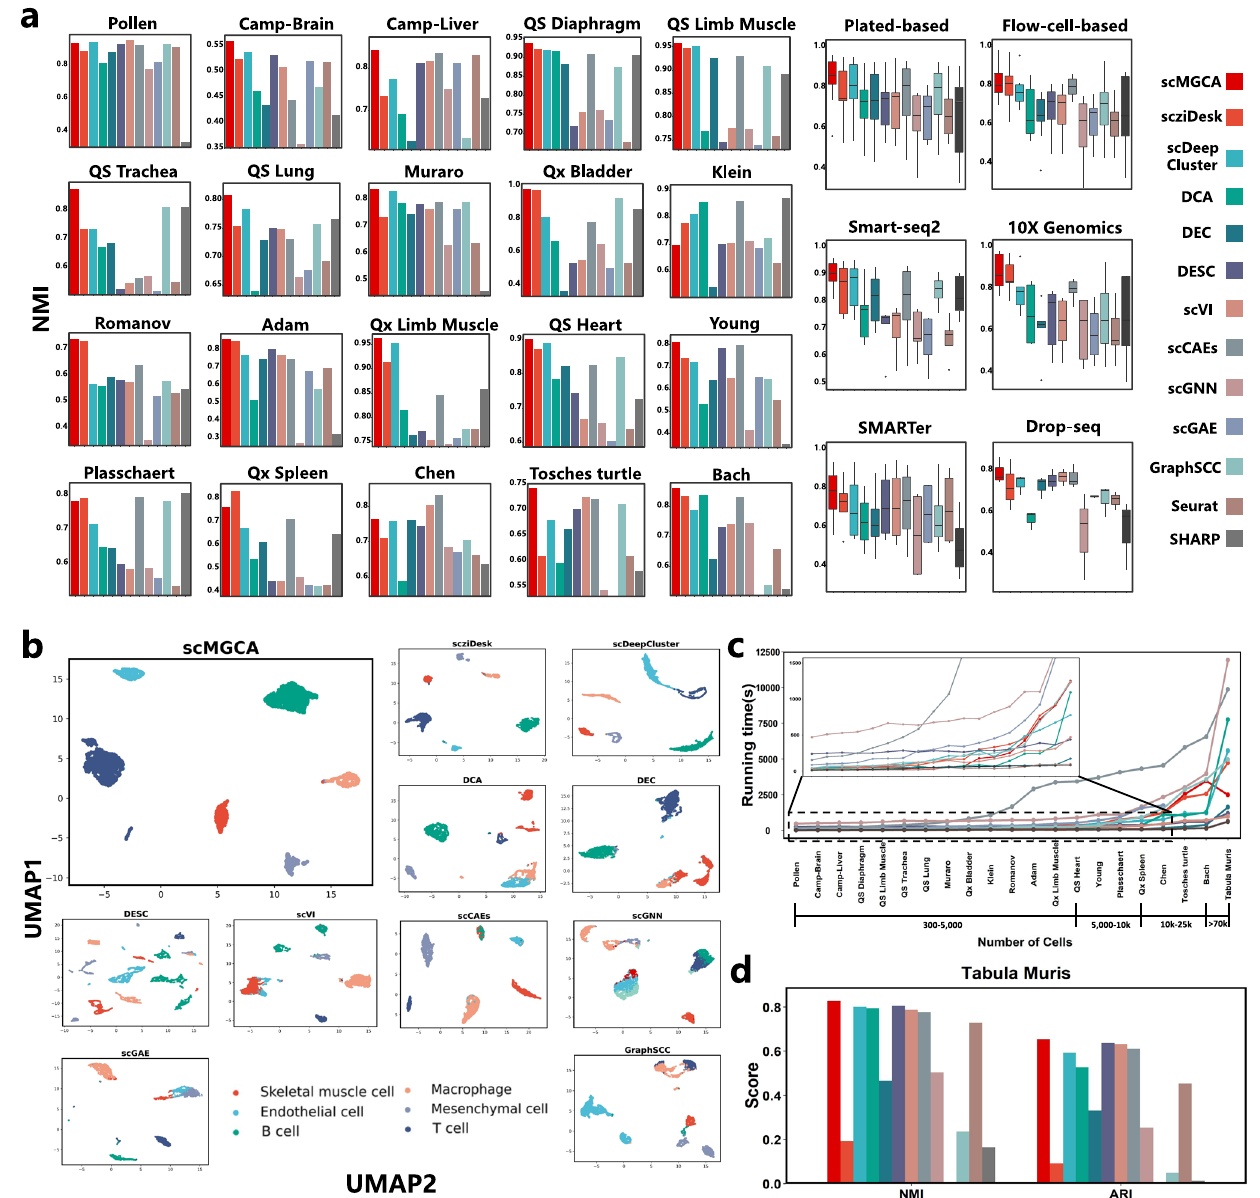
Fig.2|CellclusteringperformanceofscMGCAcomparedtootherstate-of-the- art clustering methods. a Comparisons of NMI values between scMGCA and 12 single-cell clustering methods on 20 real scRNA-seq datasets across multiple plat- forms(left, n =1ineachgroup)andondifferentplatforms(right, n =10,10,5,5,4,3 in eachgroup;centerline, median;boxlimits, upper and lowerquartiles;whiskers, 1.5×interquartile range). b Comparison of clustering results with 2D visualization